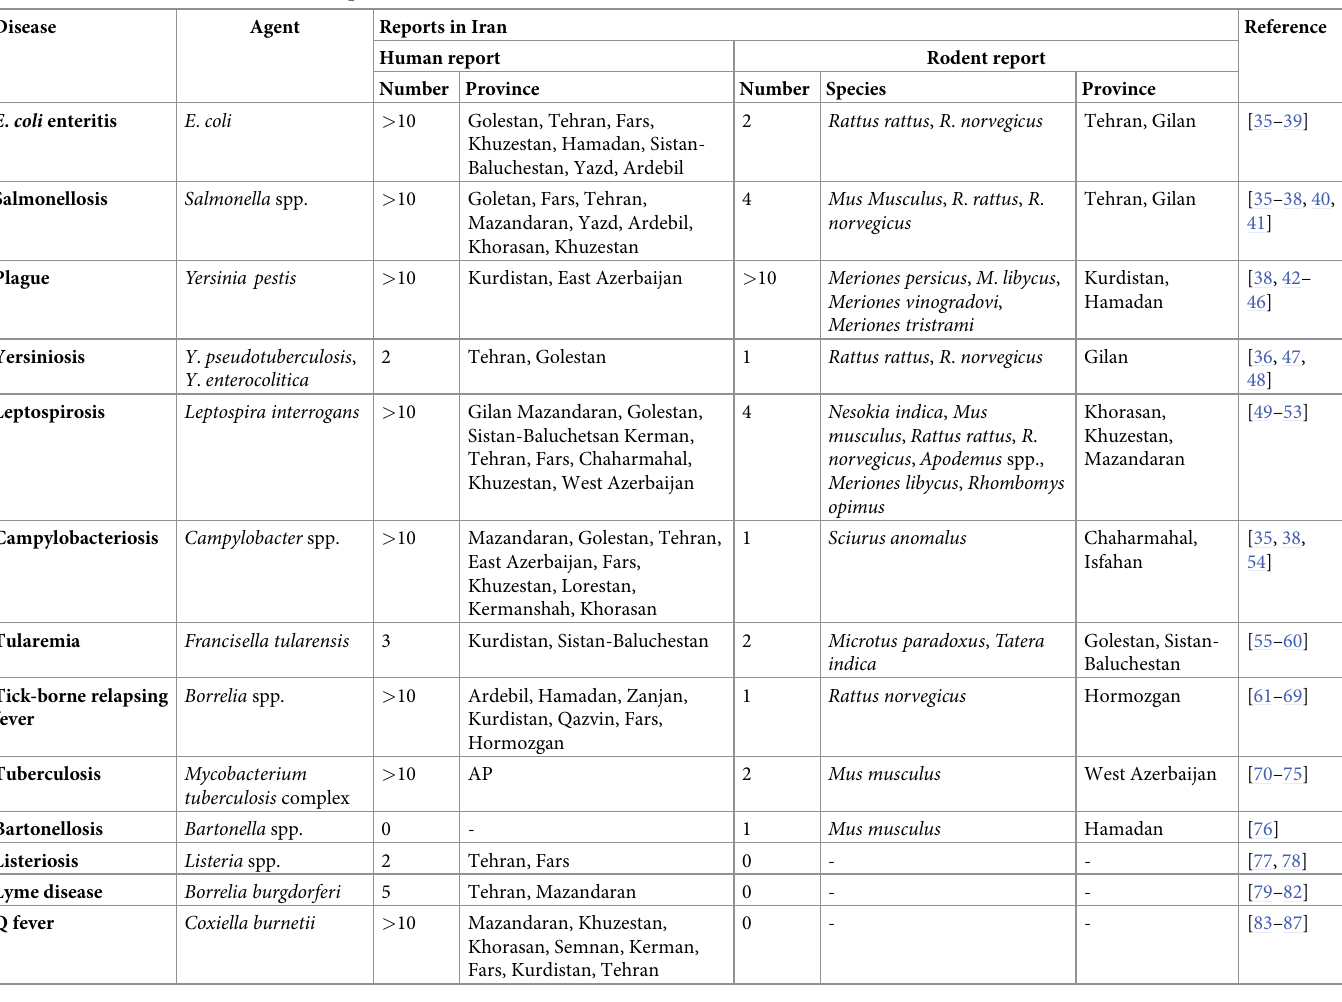
Table 1. Bacterial rodent-borne diseases reported in Iran. Disease